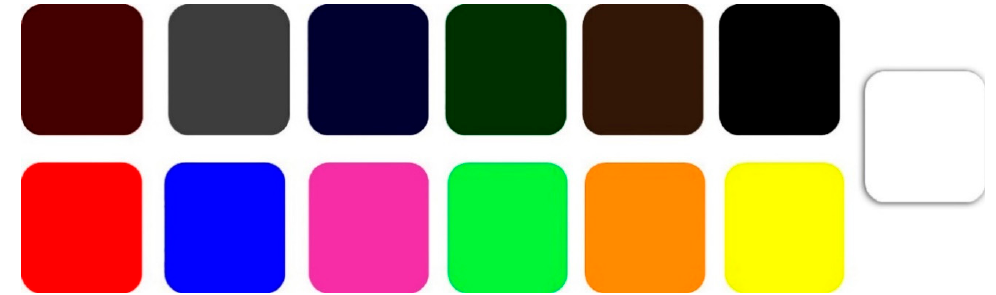
Figure 3. The displayed color samples that participants were asked to choose from in order to express their emotions after imagining a food consumption experience. Source: researcher’s own design.